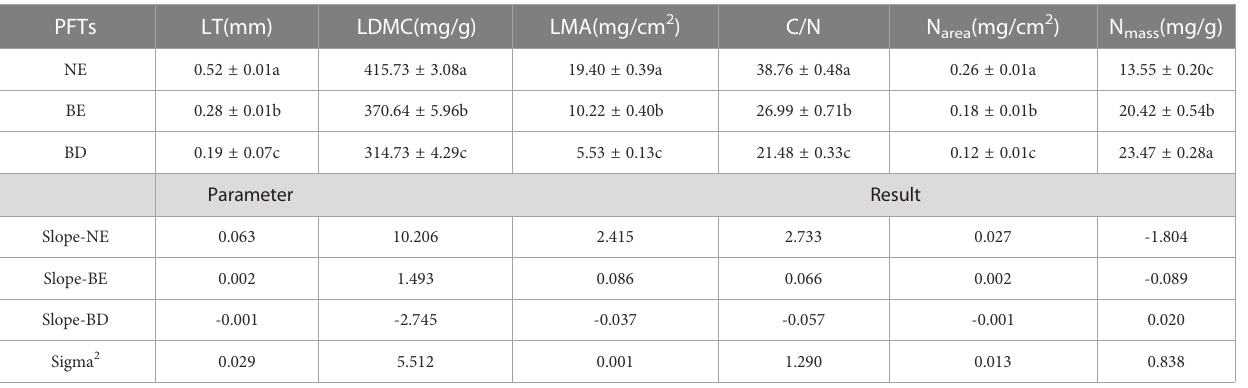
TABLE 1 Differences of leaf traits among different